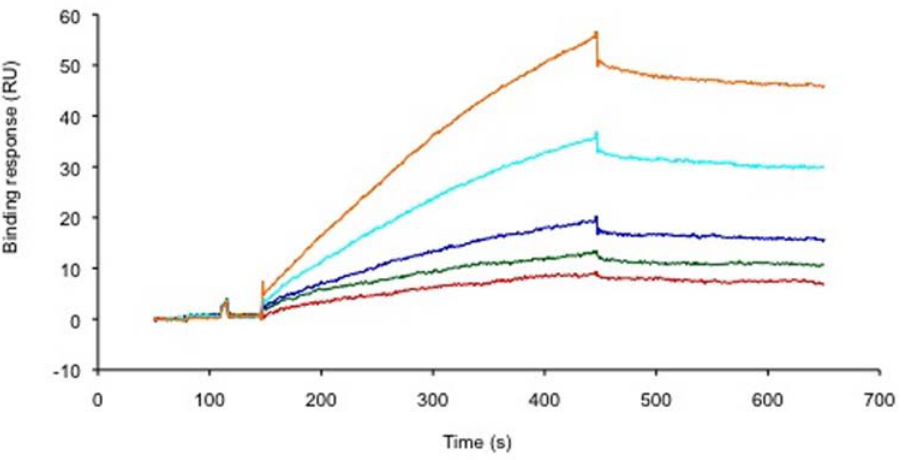
Figure 7. The LukS-PV signal peptide binds to heparan sulfates in a solid phase assay. Overlay of sensorgrams obtained when LukS-PV signal peptide at (from top to bottom) 45, 30, 20, 13.3 and 8.9 m g/ml was injected for 5 minutes at 50 m l/min over a HS activated sensorchip. The Binding response (in RU) was recorded as a function of time (in s). doi:10.1371/journal.pone.0005042.g007 PLoS ONE |